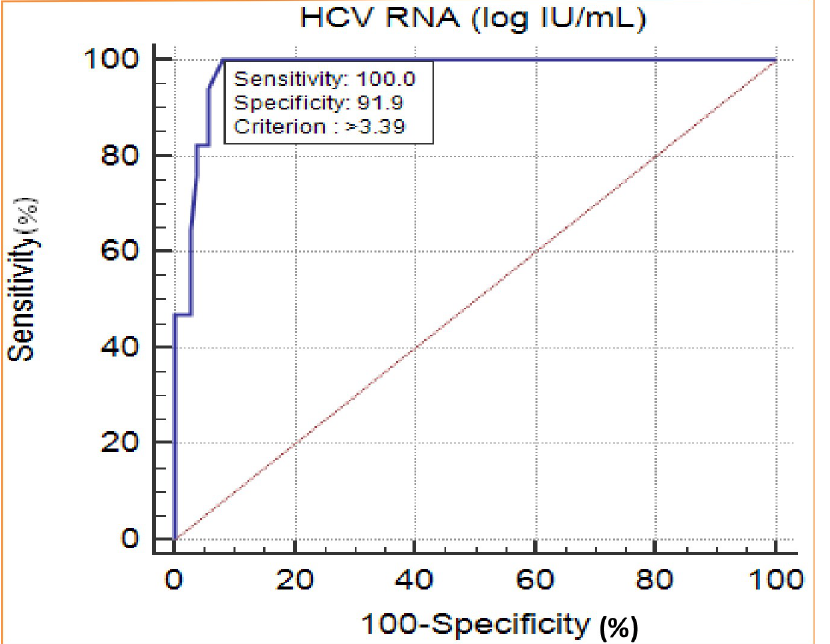
Fig 8. Receiver operating characteristic curve (ROC)